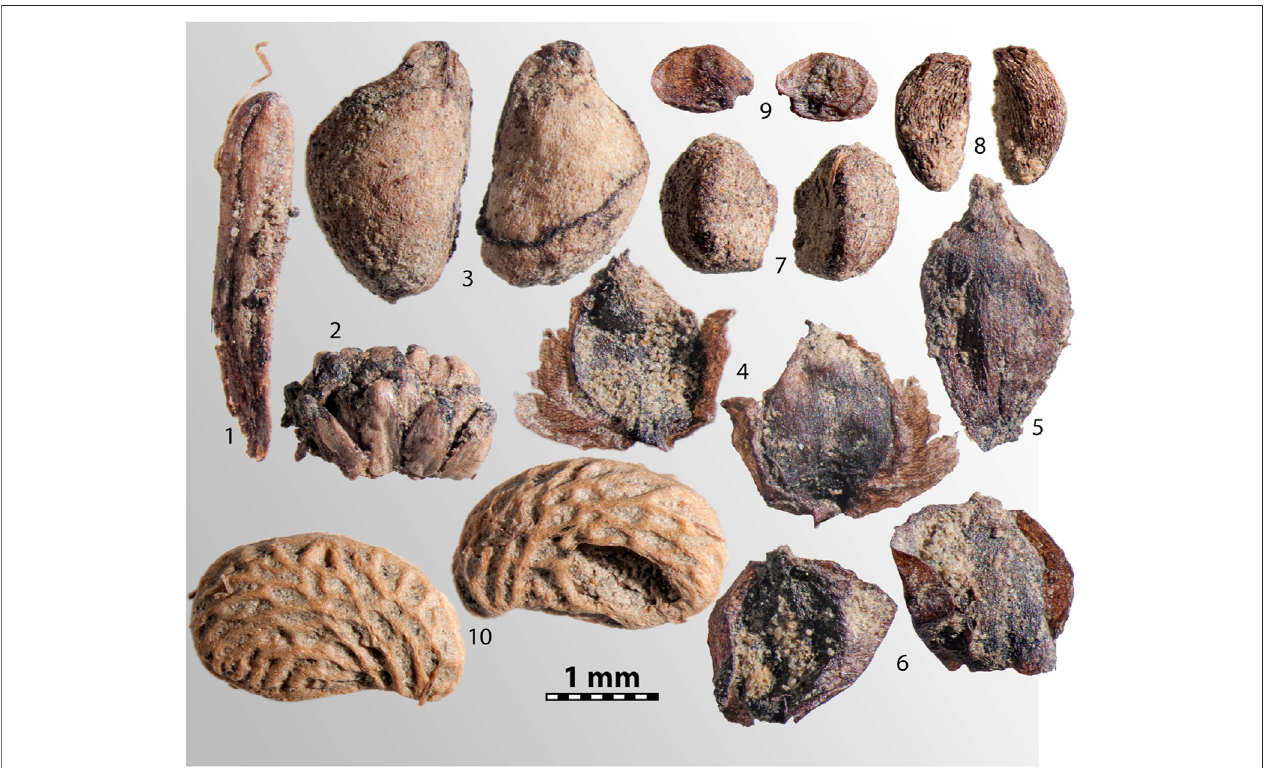
FIGURE3| Olyorianmacrofossilsofwoodland plants.1 – Larixgmelinii s.l.,needlefragment,2 – L.gmelinii s.l.,spurbranchfragmentwithyoungneedlespreserved, 3 – L. gmelinii s.l., seed from two sides, wing is not preserved but the attachment scar of the former wing is distinct, 4 – Betula cf. fruticosa , nutlet with partly preserved wingsfrom both sides,5 – Betula cf. Sect Albae , nutlet, wingsare not preserved but maximum width in upper third suggests assignment totreebirch,6 – Betula nana s.l., nutlet with completely preserved wings from both sides, 7 – Empetrum nigrum , seed from two sides, 8 – Vaccinium vitis-idaea , seed from both sides, 9 – Stellaria longifolia , seed from both sides, 10 – Rubus idaeus , pyrene from two sides.